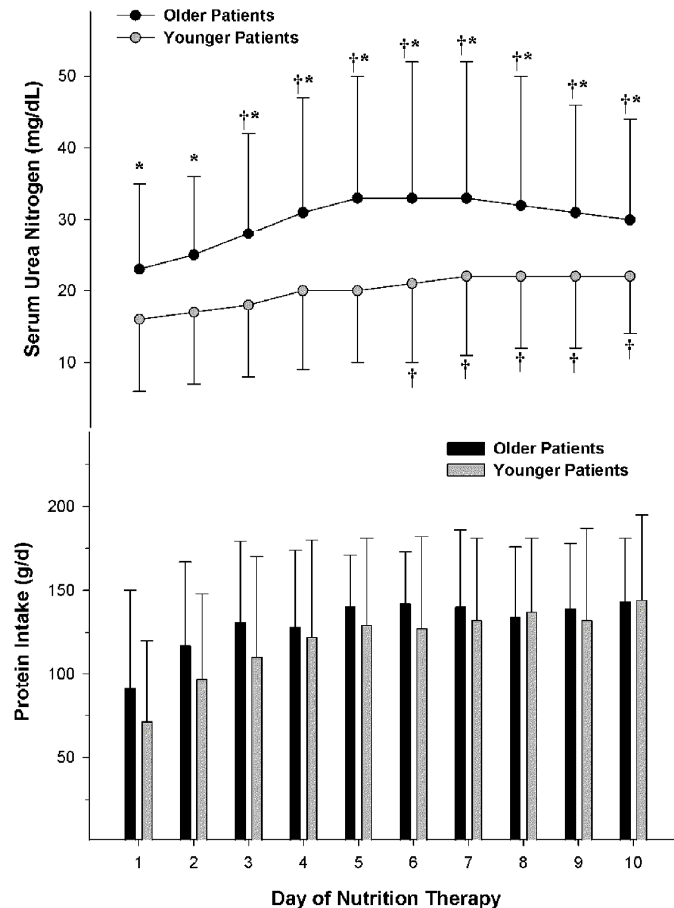
Figure 3. Serum urea nitrogen concentrations and protein intake during hypocaloric, high protein nutrition therapy in older vs. younger critically ill patients with obesity and traumatic injuries. Serial serum urea nitrogen concentrations were greater for older compared to younger patients ( p = 0.001) despite isonitrogenous daily intakes between age groups. * p = 0.05 between age groups. † p = 0.05 from day 1. Reprinted with permission from Dickerson, R.N.; Medling, T.L.; Smith, A.C.; Maish, G.O.,